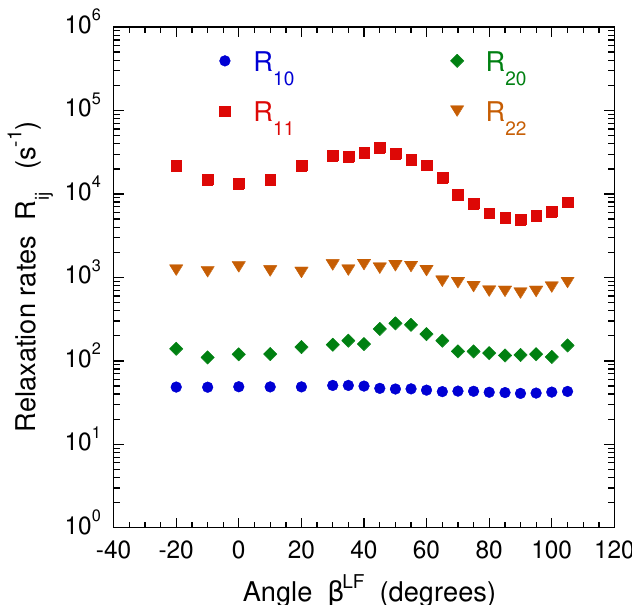
Figure 7. Variation of the relaxation rate of the T 10 , T 11 ( a , s ) , T 20 , and T 22 ( a , s ) coherences, noted R 10 , R 11 ( a , s ) , R 20 , and R 22 ( a , s ) , respectively, as a function of the orientation β LF of the clay film into the static magnetic field. Reprinted with permission from Ref. [80]. Copyright (2014) American Chemical